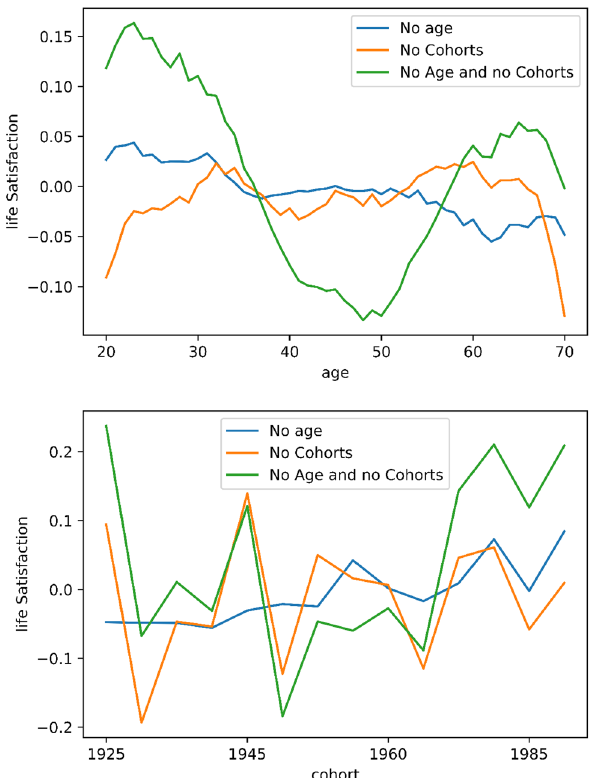
Figure 2. Predictions of life satisfaction on test data. The figure shows the differences in the baseline model predictions (including age and cohorts) and the models excluding age, cohort, and age and cohort. Differences are shown by age (top panel) and cohorts (bottom